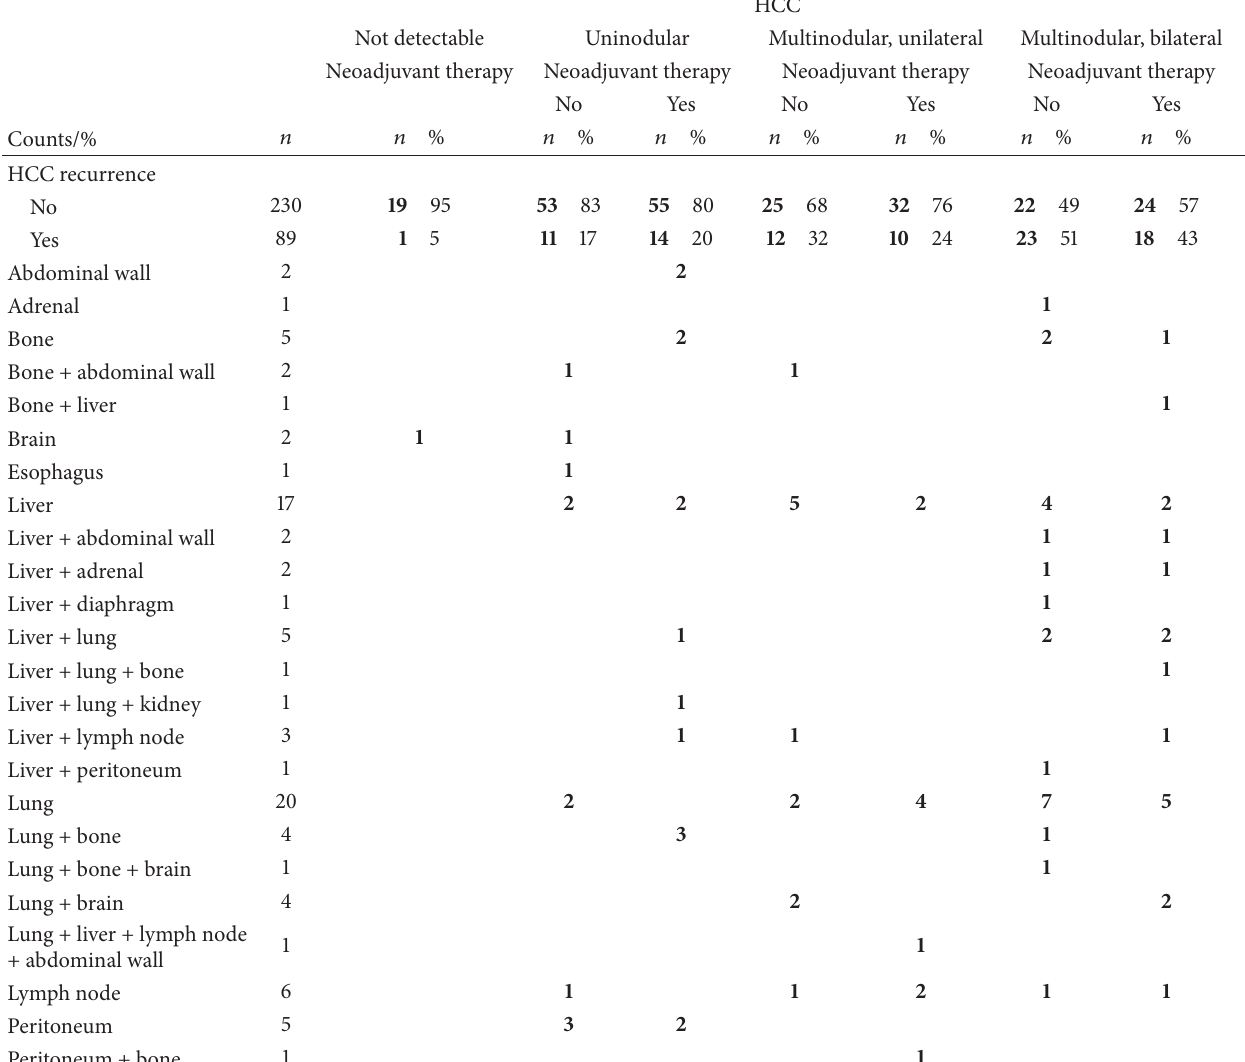
Table 3: Rate and anatomical sites of HCC recurrences with respect to tumor morphology and neoadjuvant